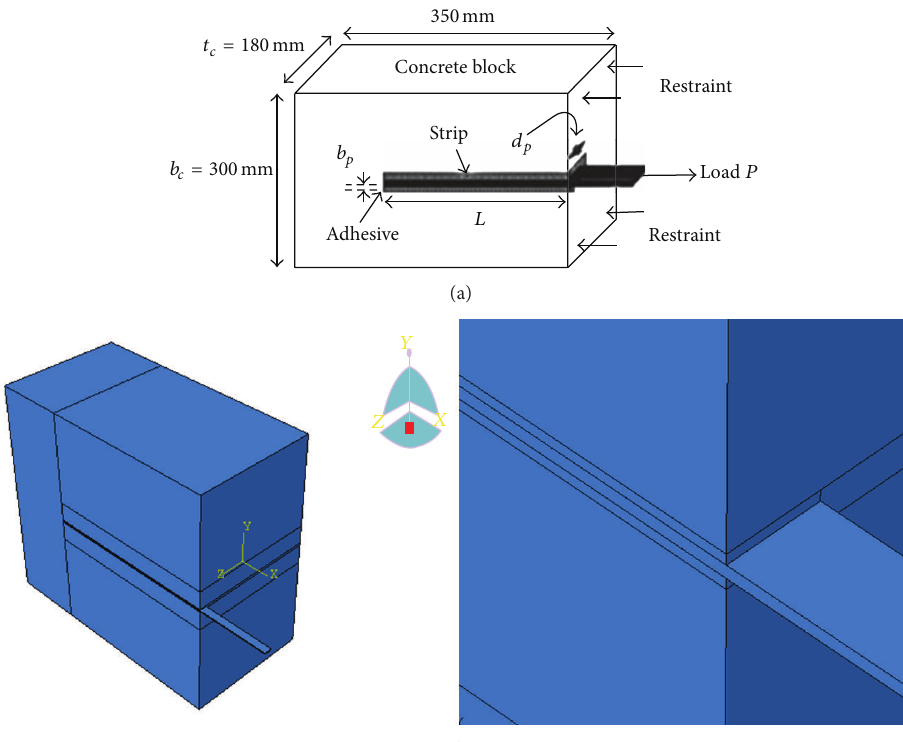
Figure 2: The detailed reinforced system